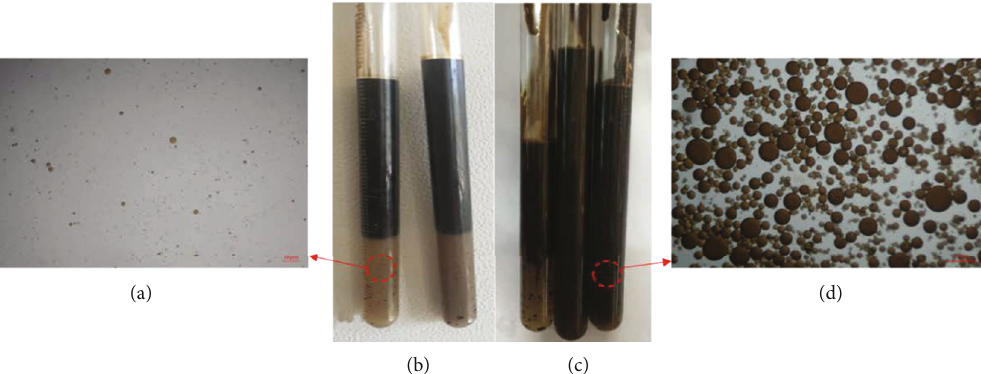
Figure 3: Comparison of e ffl uent in SP fl ooding and emulsion fl ooding following SP fl ooding. (a) Microscopic photos of e ffl uent of SP fl ooding. (b) E ffl uent of SP fl ooding in a tube. (c) E ffl uent of emulsion fl ooding in a tube. (d) Microscopic photos of e ffl uent of emulsion fl ooding.